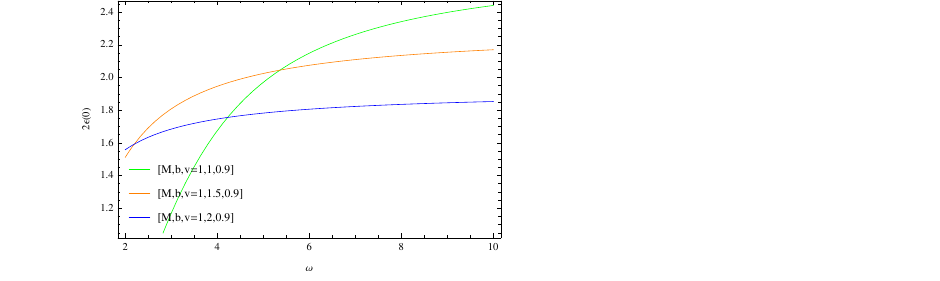
Figure 9. The variation in the total deflection 2 (cid:101) ( 0 ) at φ = 0 with respect to the coupling constant ω for different values of the impact parameter b .